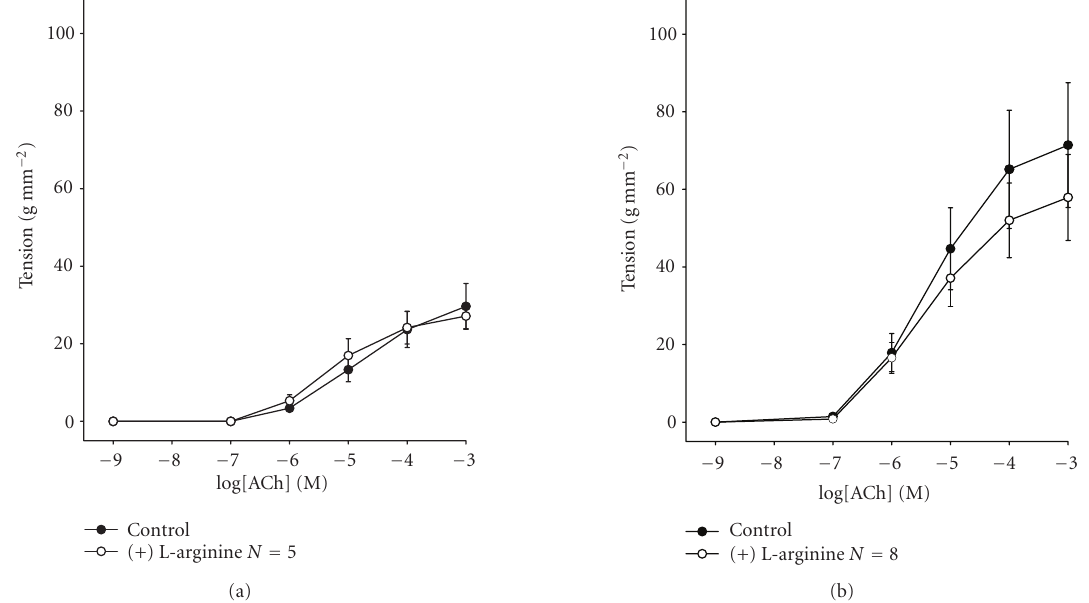
Figure 4: Concentration-e ff ect curves for acetylcholine at an RT of 0.5 g (a) and 2.5 g (b) in the presence of L-arginine. Data are means and vertical lines show SE. N refers to the number of animals